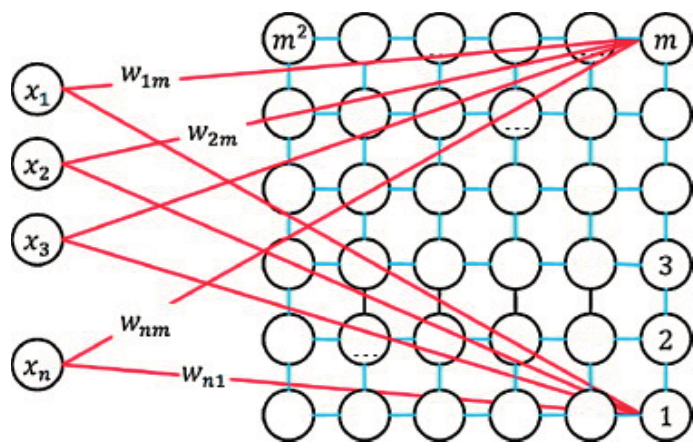
Figure 3. Schematic layout of a self-organizing map adapted from